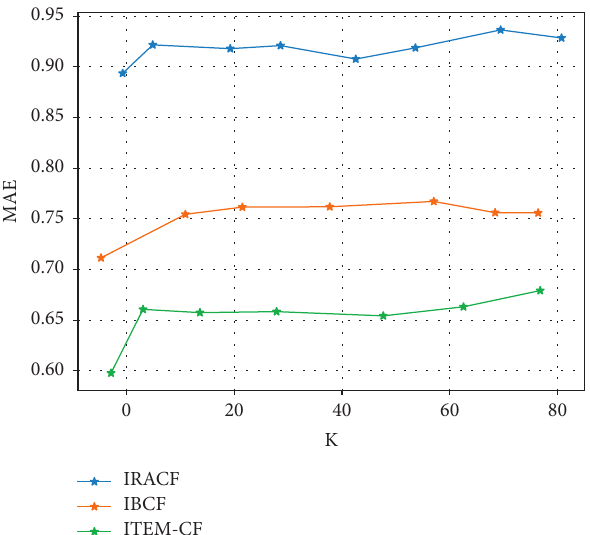
Figure 7: Comparison results of the same algorithm.